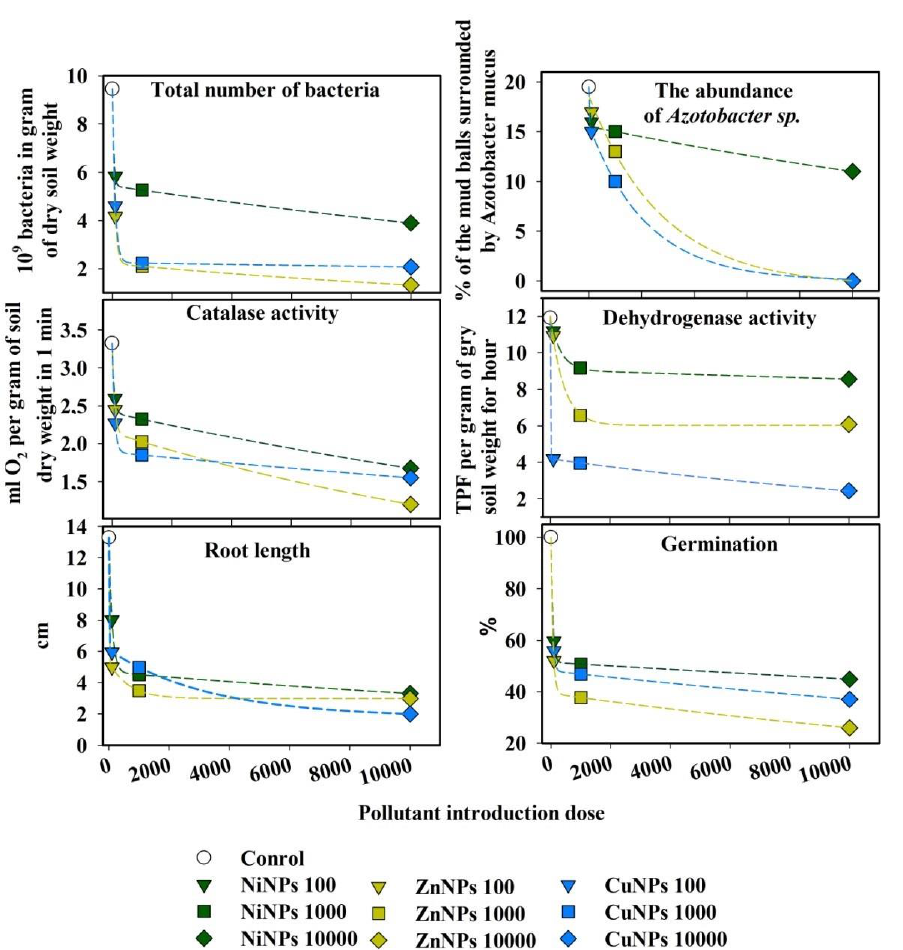
Figure 4. The relationship between the suppression of the microbiological and enzyme indicators of the Cambisols, germination of seeds, and the application rates of various NPs.